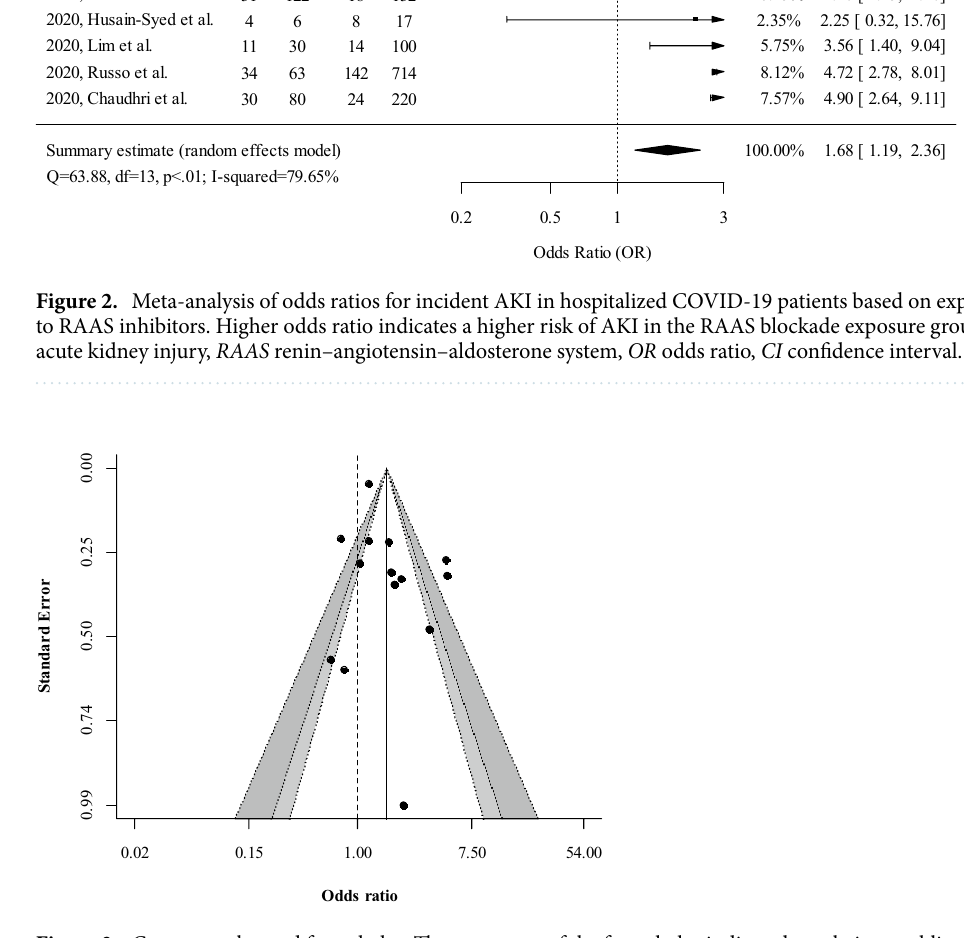
Figure 3. Contour-enhanced funnel plot. The symmetry of the funnel plot indicated no obvious publication bias. Inner white zone indicates P-value > 0.1, gray zone indicates 0.05 < P-value < 0.1, dark gray zone indicates 0.01 < P-value < 0.05, and outer white zone indicates P-value <